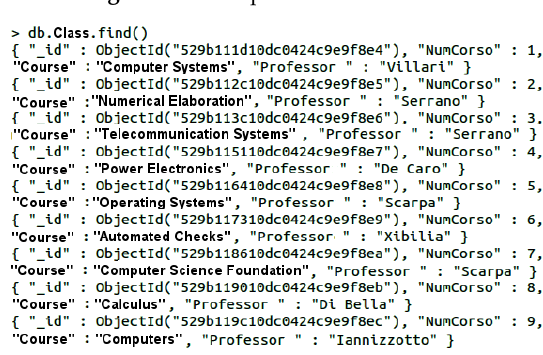
Figure 10. Example of Exam collection.